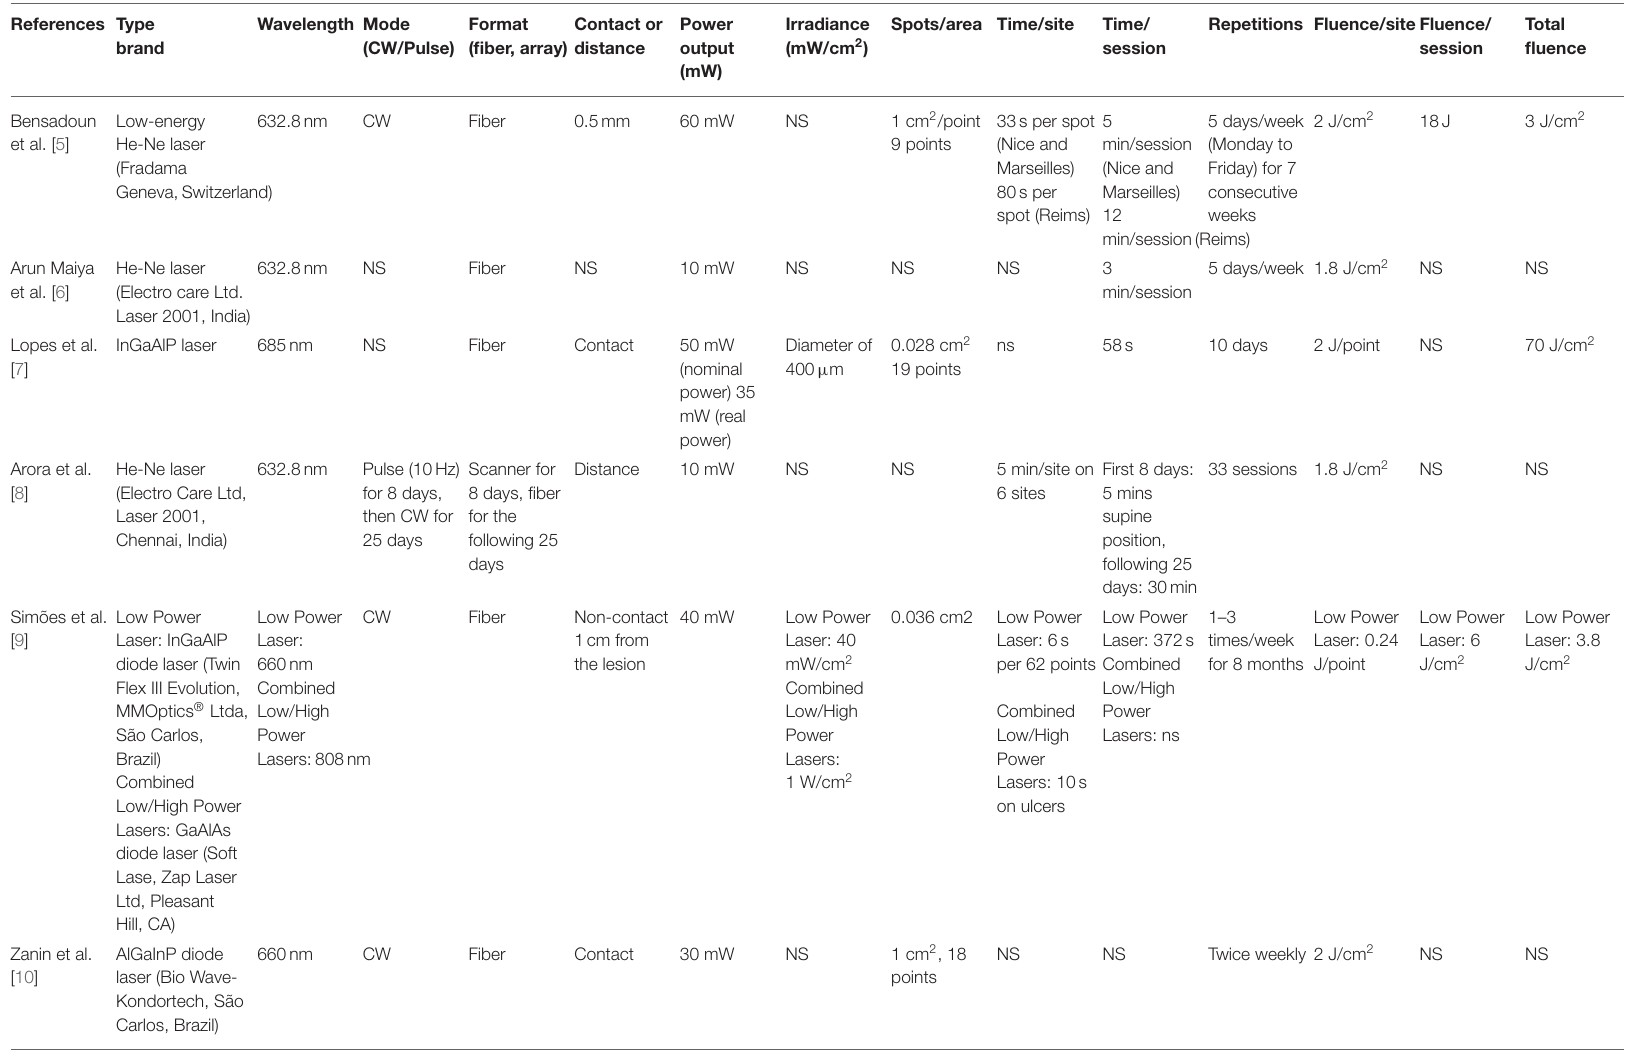
TABLE 2 | Laser parameters of the studies included in the narrative